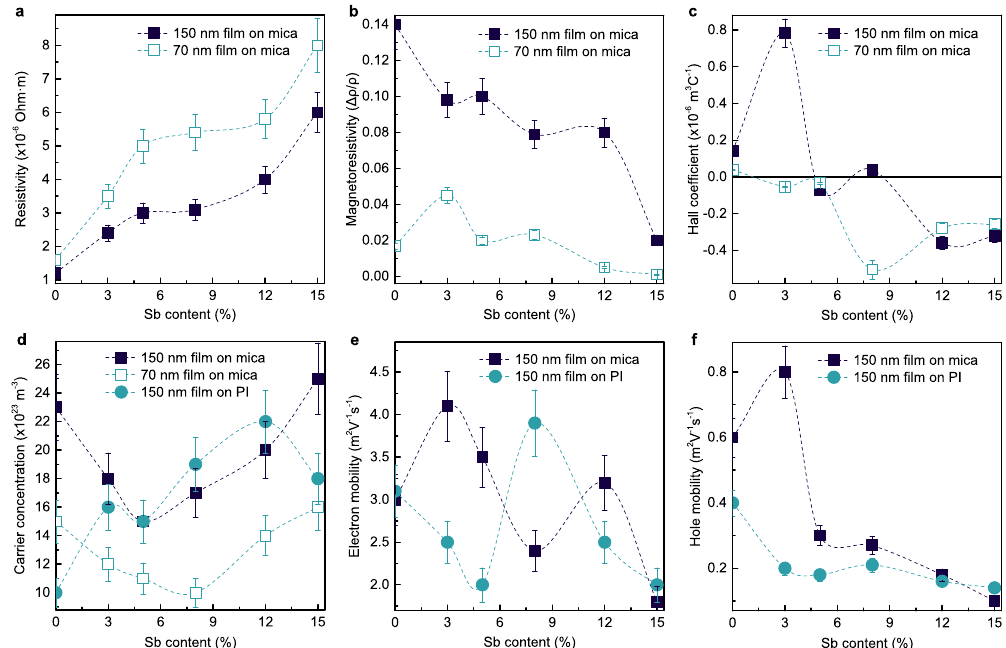
Figure 2. The dependencies of Bi 1 − x Sb x sheet resistivity ( a ), magnetoresistivity ( b ) and Hall coefficient ( c ) on Sb concentration x for 150 nm and 70 nm films on mica substrate. ( d ) The same for carrier concentration in 150 nm films on mica and PI substrates and for 70 nm film on mica